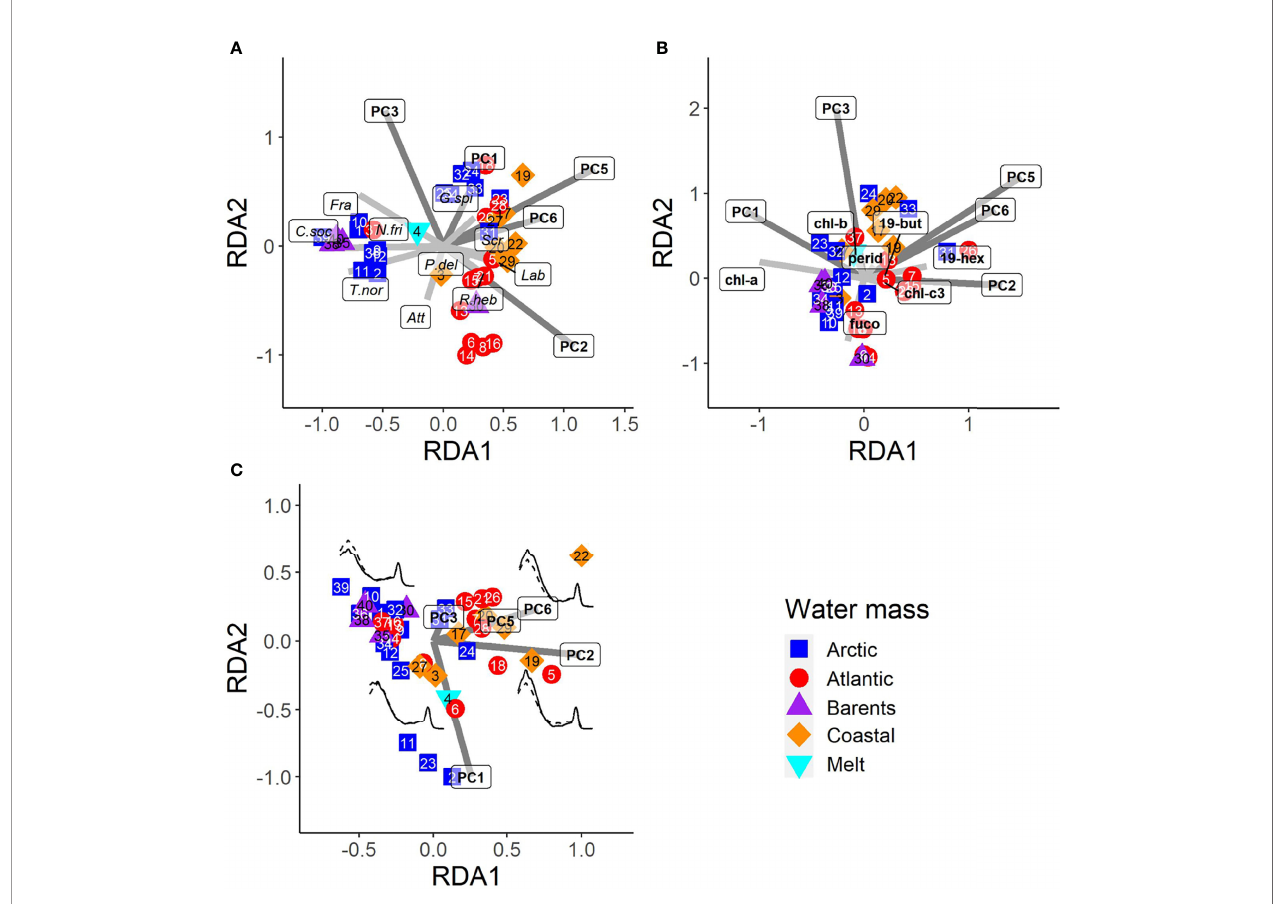
FIGURE 6 | (A) RDA1-2 space for cell count structure, with salient environmental variables (PC1,2,3,5,6) and representative species vectors. ‘ C.soc ’ , Chaetoceros socialis ; ‘ T.nor ’ , Thalassiosira nordenskioeldii ; ‘ N.fri ’ , Nitzschia frigida ; ‘ Fra ’ , Fragilariopsis ; ‘ Lab ’ , Laboea ; ‘ Att ’ , Attheya ; ‘ P.del ’ , Pseudo-nitzschia delicatissima ; ‘ Scr ’ , Scrippsiella ; ‘ G.spi ’ , Gyrodinium spirale ; ‘ R.heb ’ , Rhizosolenia hebetata . (B) RDA1-2 space for pigment structure, with salient environmental variables and pigment contribution vectors. ‘ chl-a ’ , chlorophyll-a; ‘ chl-b ’ , chlorophyll-b; ‘ chl-c3 ’ , chlorophyll-c3; ‘ fuco ’ , fucoxanthin; ‘ 19-hex ’ , 19 ′ -hexanoyloxyfucoxanthin; ‘ 19-but ’ , 19 ′ - butanoyloxyfucoxanthin; ‘ perid ’ , peridinin. (C) RDA1-2 space for absorption spectra, with salient environmental variables and representative absorption spectra (400-750 nm), normalised to absorption at 676 nm. A dashed line represents the mean absorption spectrum across all samples. Samples are identi fi ed by unique